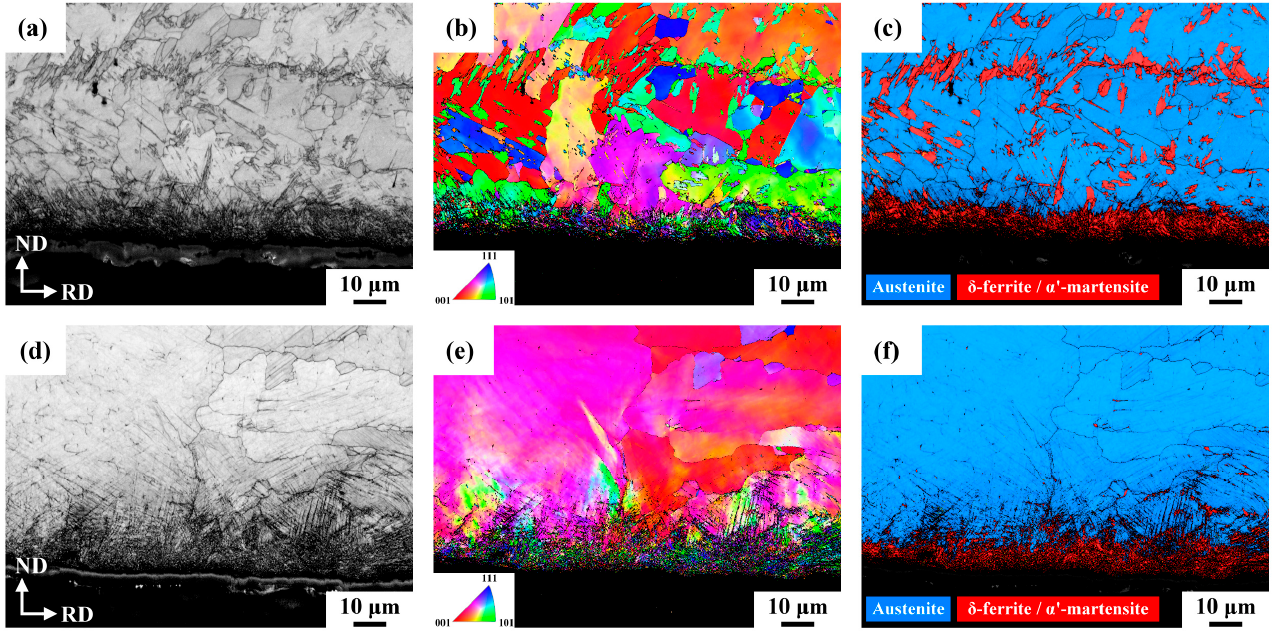
Figure 7. EBSD: ( a ) and ( d ) BC maps, ( b ) and ( e ) IPF maps, ( c ) and ( f ) phase maps of the U-bend samples with micro-shot peening around the FZ in cross-sectional view. ( a ), ( b ) and ( c ) the 304 weld; ( d ), ( e ) and ( f ) the 316 weld. The microstructures around the FB in the U-bend welds with micro-shot peening are presented in Figure 8 in a cross-sectional view. The BC maps and IPF maps of the micro-shot peened sample (Figure 8) were similar to those of the non-peened sample (Figure 5). The phase maps (Figure 8c,f) showed that micro-shot peening caused intense deformation on the top surface around the FBs of the two welds, resulting in the formation dense α (cid:48) -martensite but only to a finite depth. Thus, the application of intense micro-shot peening in distinct zones of the austenitic SS welds was expected to cause an obvious change in the surface microstructure of the